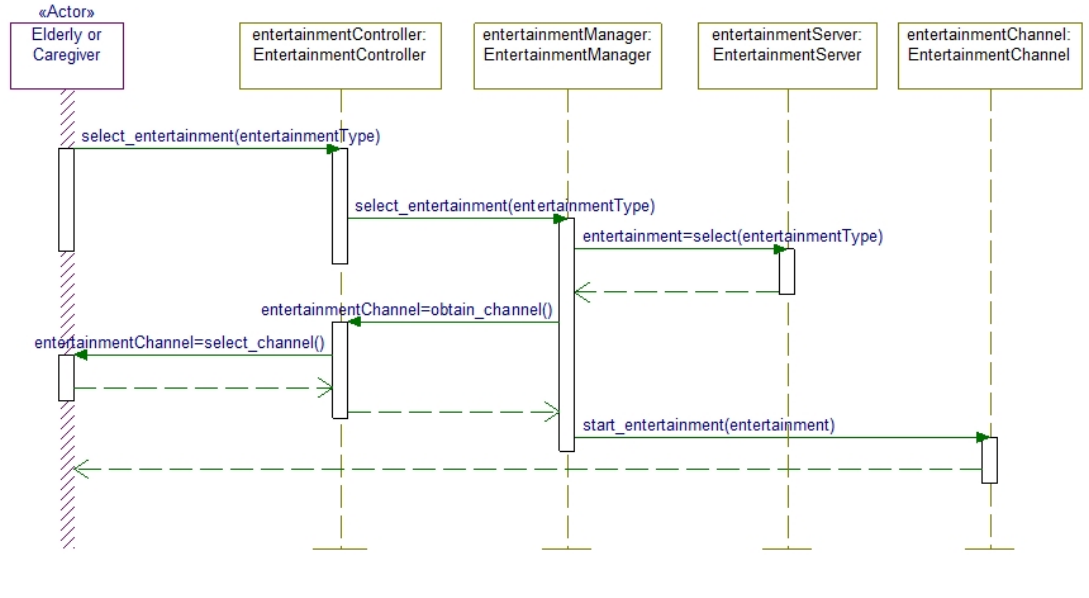
Explicit interaction mode where the elderly or the caregiver